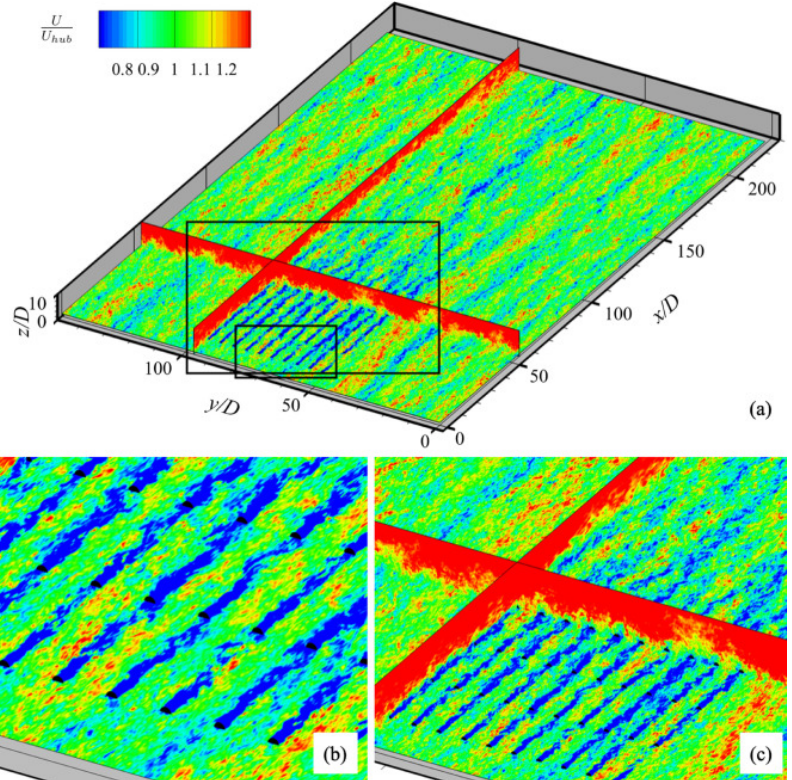
Figure 15. A simulation of wind farm wake by using AD-LES. ( a ) contours of the instantaneous streamwise velocity at hub height; ( b , c ) zoomed-in contours. Reprinted from Dong et al. [138] under Creative Commons Attribution